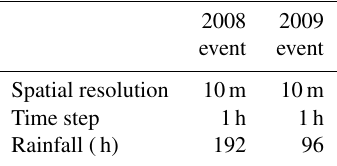
Table 3. Main characteristics of the